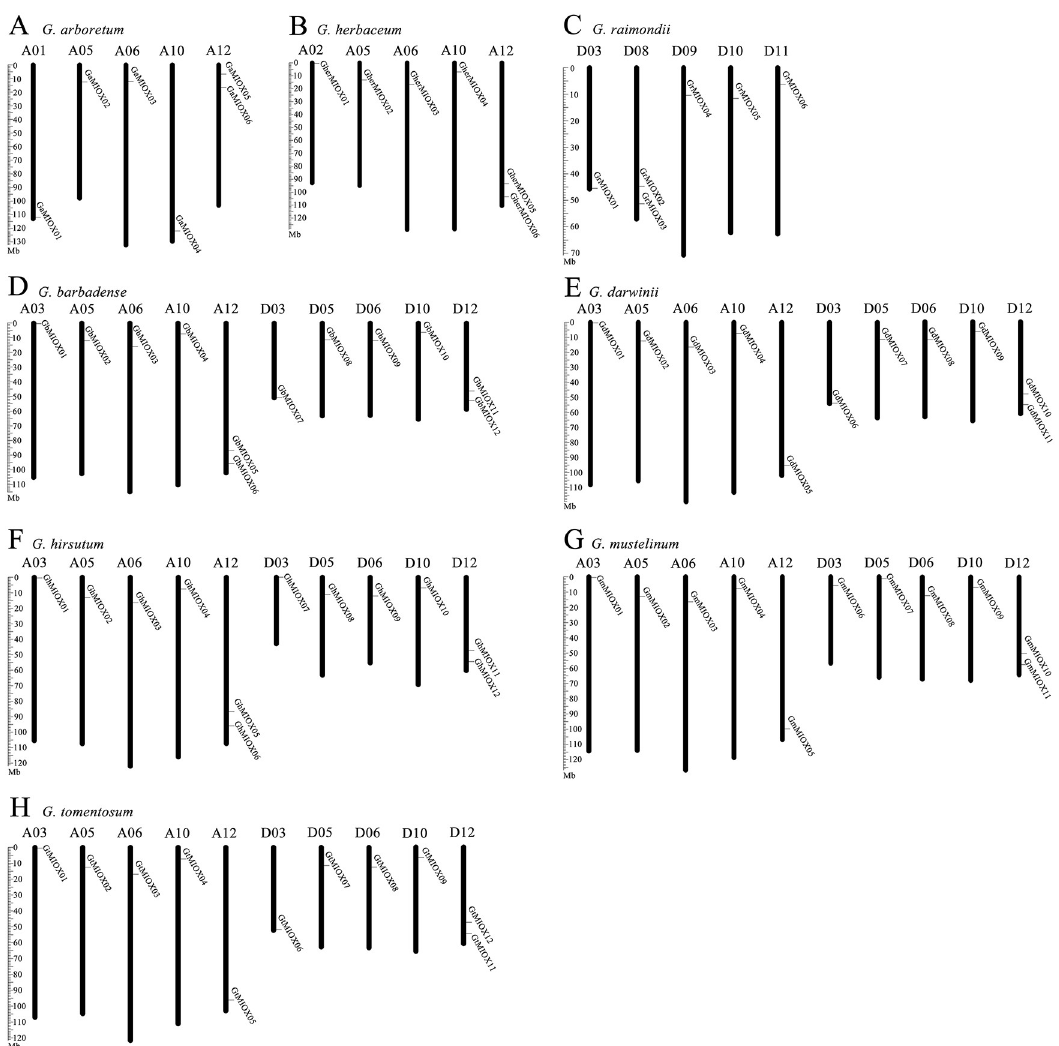
Fig 3. Distribution of the MIOX genes on the cotton chromosomes. The vertical bar located on the left side indicates the chromosome sizes in mega bases (Mb), the chromosome number is located above each